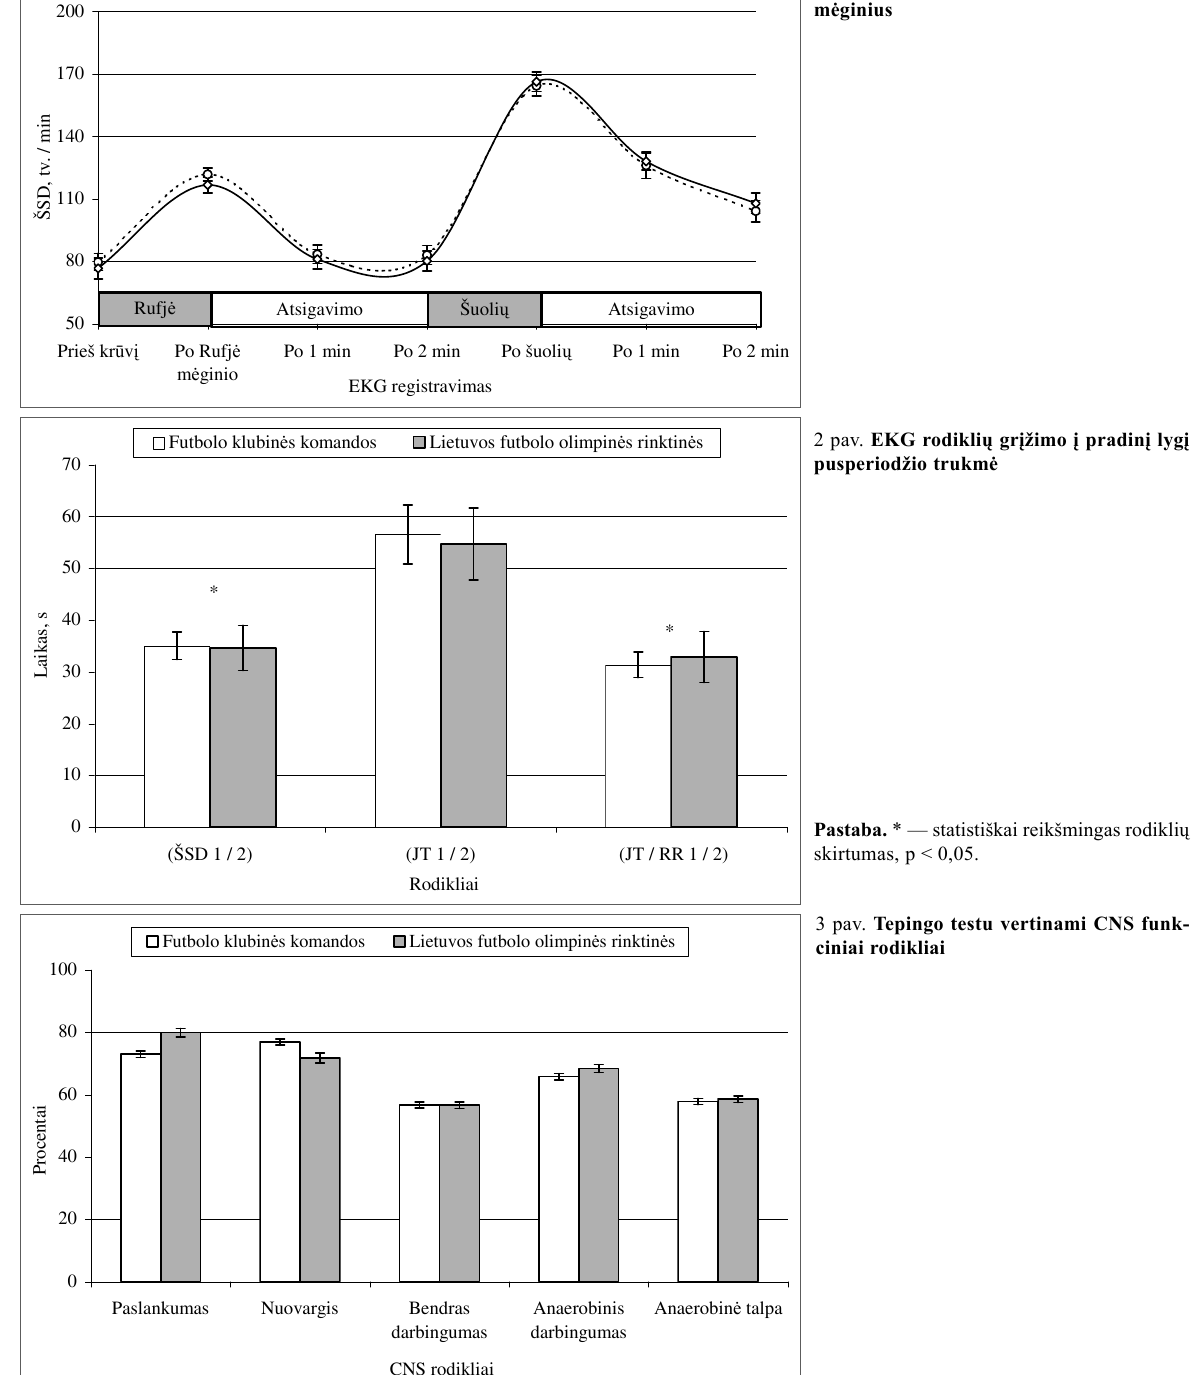
Pastaba. * — statistiškai reikšmingas rodikli ų skirtumas, p < 0,05. 3 pav. Tepingo testu vertinami CNS funk- ciniai